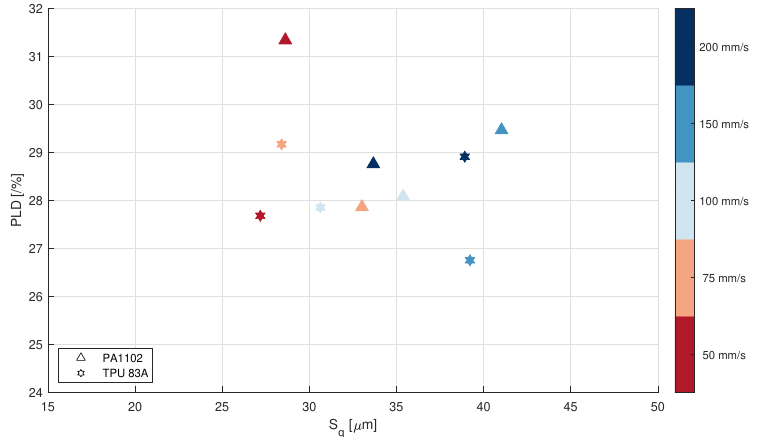
Figure 8. PLD vs. S q for PA1102 and TPU 83A (different